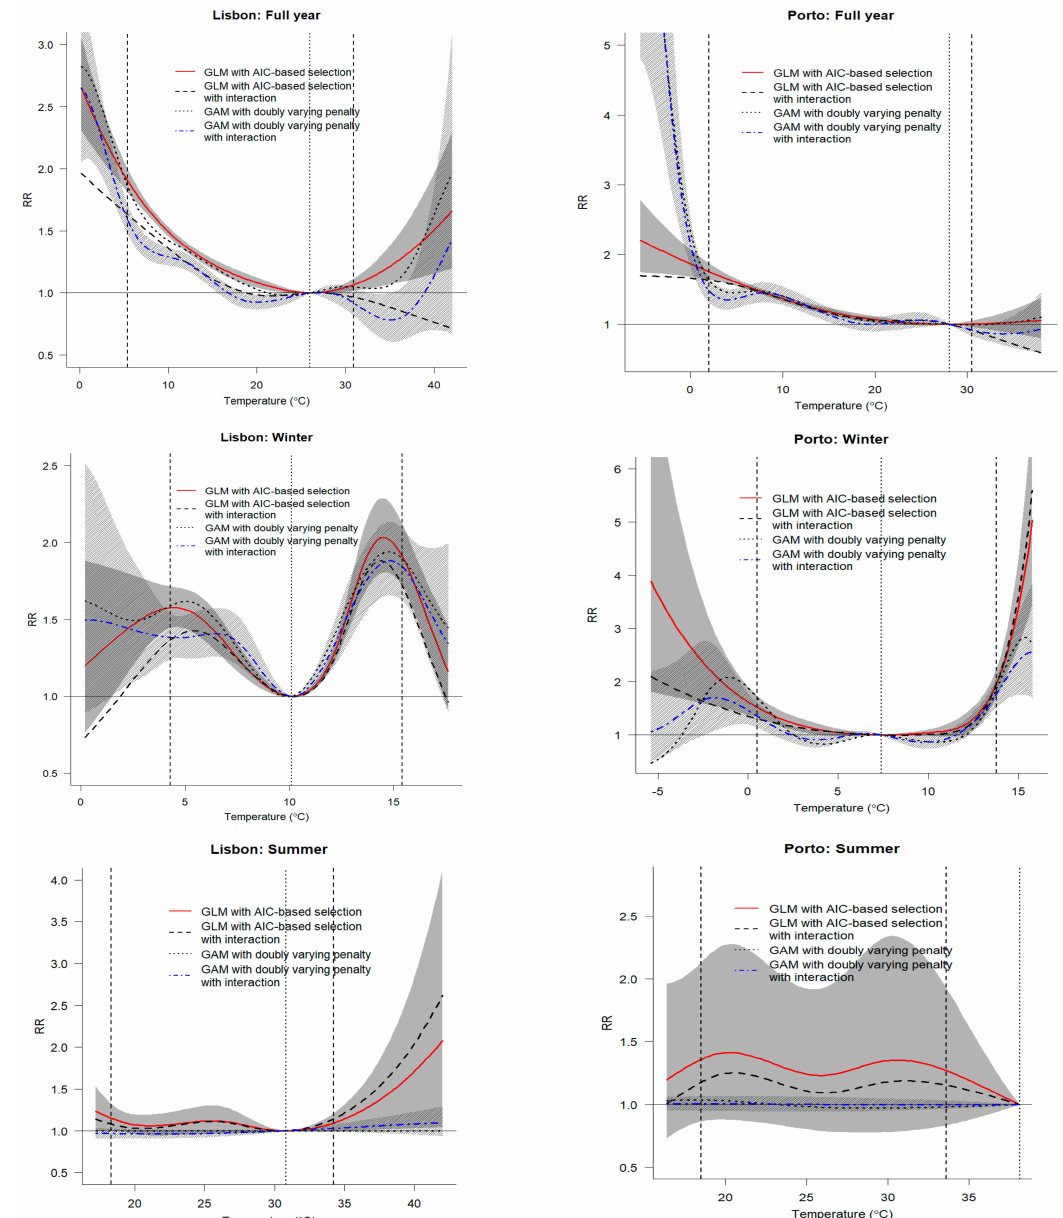
Figure 3. Overall cumulative exposure–response curves for the relationship between daily temperatures and mortality for the historical data (1986–2005) over lags of 0–30 days for di ff erent model specifications. The minimum mortality temperature (dashed vertical line) stands as a reference. The broken thick black lines correspond to the 5th and 95th temperature